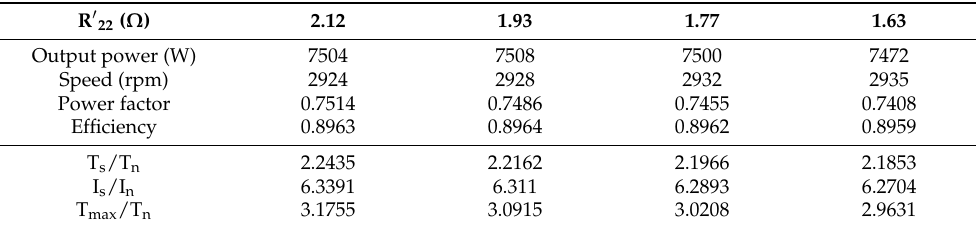
Table 7. Nominal, start, and maximum torque results on the 7.5 kW motor (equal heating criteria, variations of R (cid:48) 22 ).